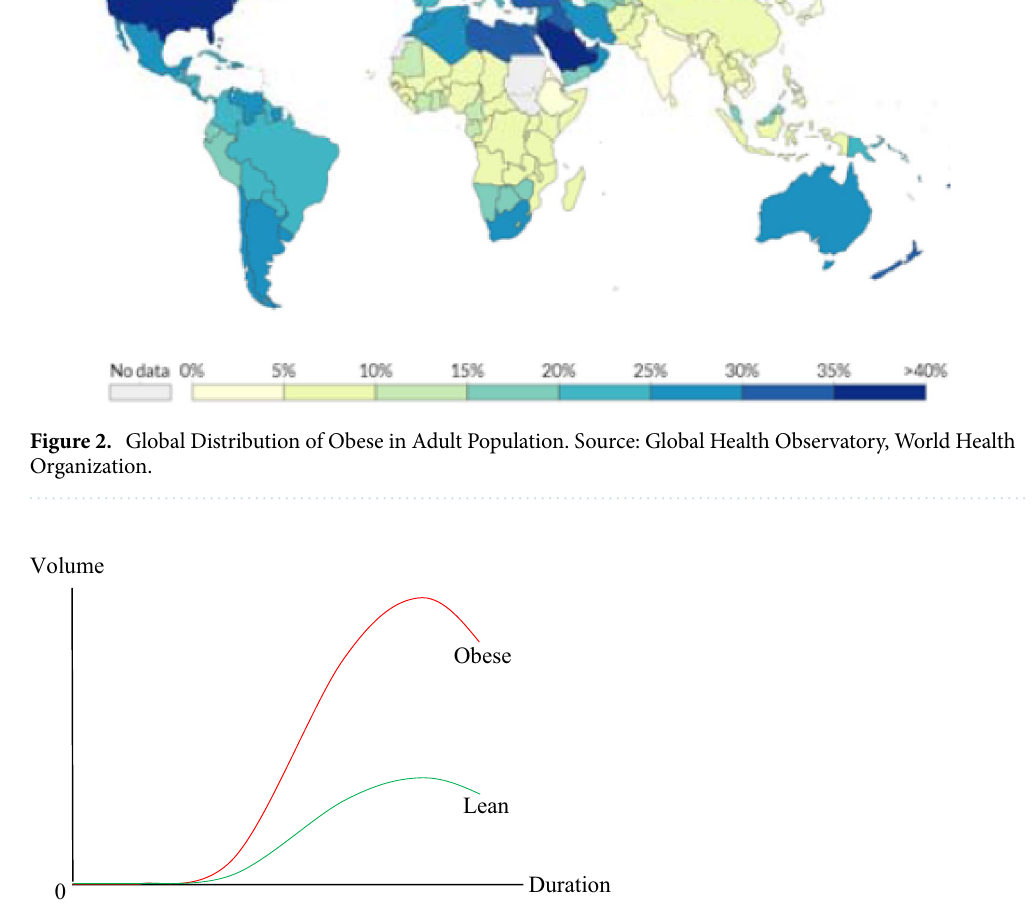
Figure 3. Volume and Duration of Viral Shedding: Obese vs. Lean 6 . Source: Honce and